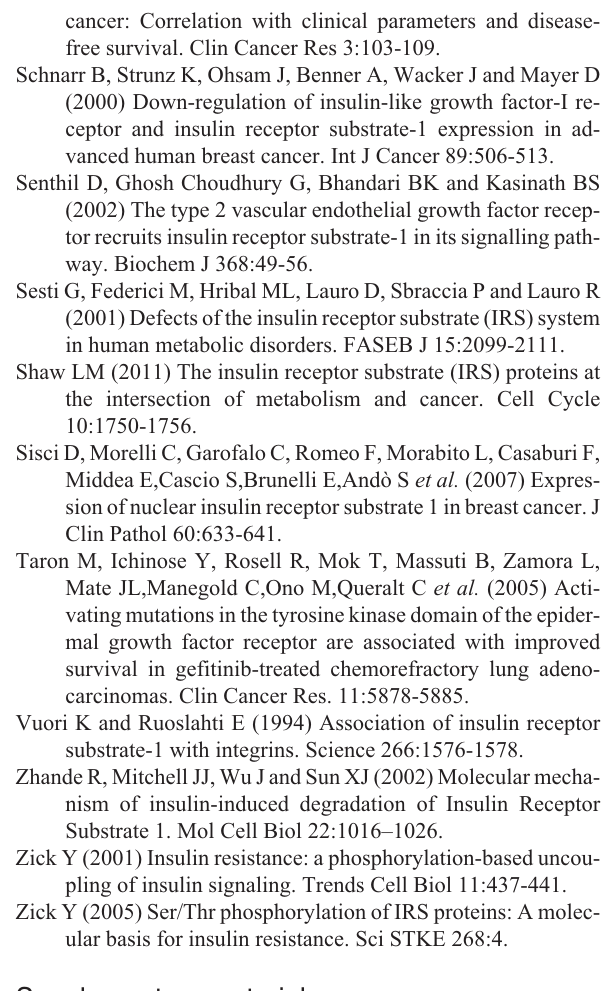
Figure S1- epresentative results for mutational analysis of: (a) IRS1 detected in tumor samples compared to matched